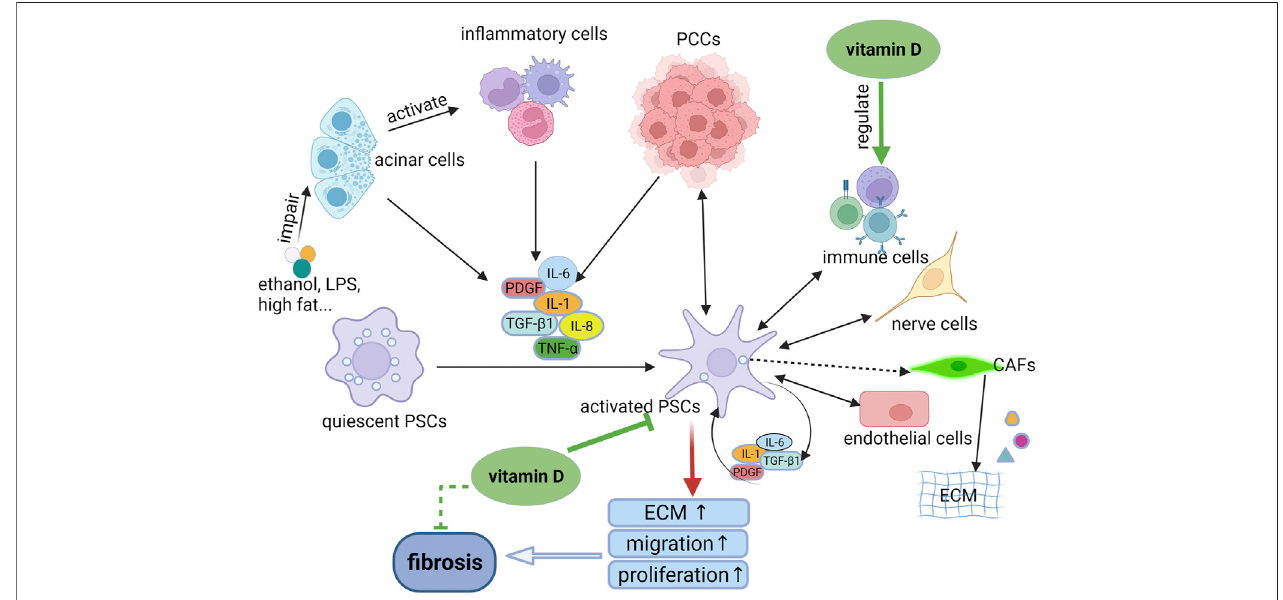
FIGURE1| ThemechanismofPSC activationandtheroleofvitaminDintheprocess.Whenthepancreasisinjuredbyethanol,LPSorotherfactors,thedamaged acinar cells can activate in fl ammatory cells to release pro-in fl ammatory cytokines which in turn activates quiescent PSCs to become activated phenotypes through paracrine stimuli. The activated PSCs can secrete cytokines to activate PSCs continuously through autocrine stimuli, resulting in pancreatic fi brosis. In addition, the activated PSCs can interact with other cell types, such as PCCs and immune cells, mediating the persistent in fl ammatory environment. Whereas, vitamin D can inhibittheactivationand proliferationofPSCs,therebyreducingthesynthesis ofECM.Inaddition, vitaminD playananti-in fl ammatoryand anti- fi brosisrole via regulation ofimmunecells.LPS,lipopolysaccharide;PSCs,pancreaticstellatecells;ECM,extracellularmatrix;PCCs,pancreaticcancercells;CAFs,cancer-associated fi broblasts.